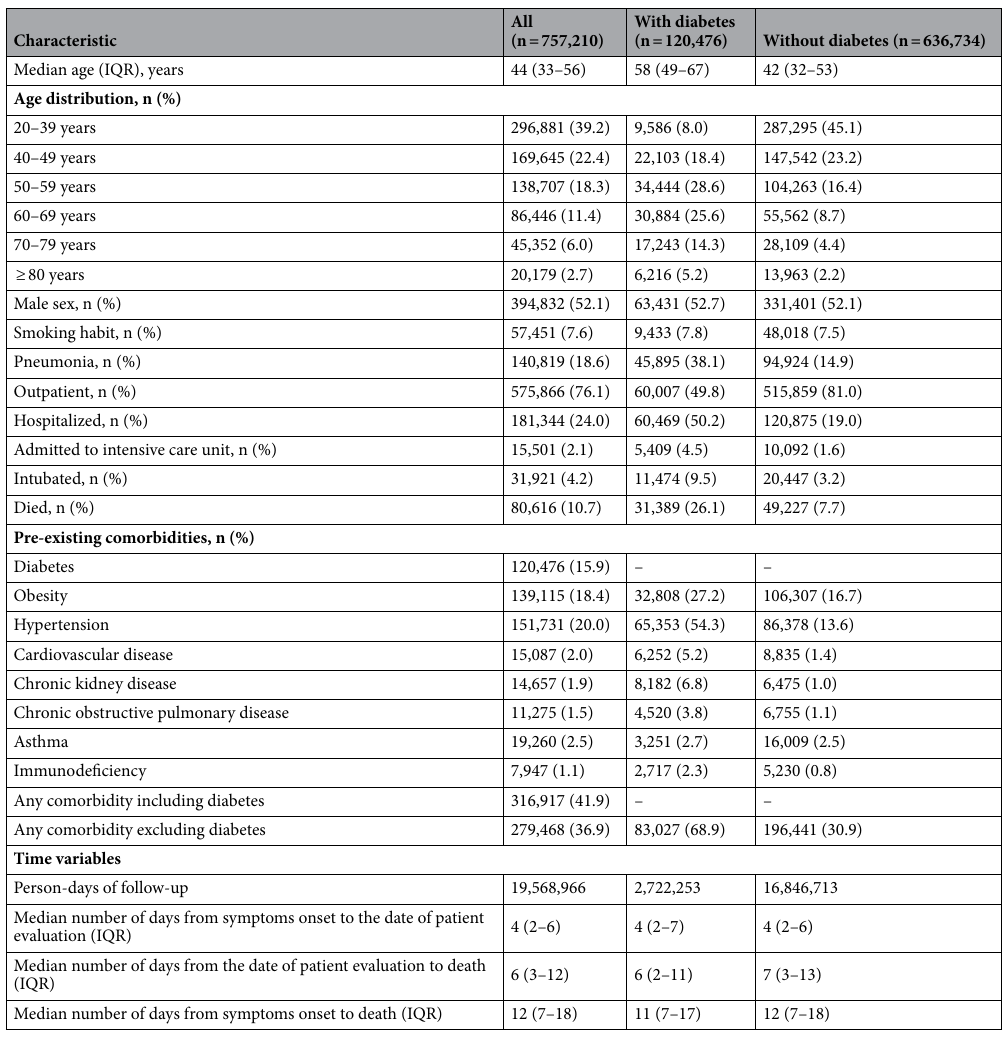
Table 1. Characteristics of study patients with